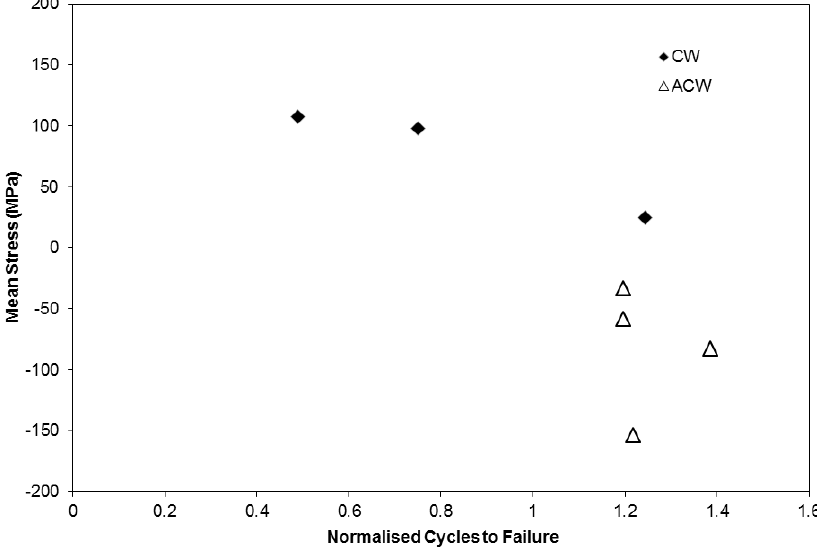
Figure 6. Mean stress vs . cycles to failure for varying phase angle tests at Δε of